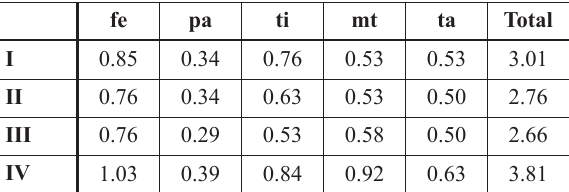
25(Fig. 3H), iridescent with a green and blue lustre. Retrocoxal hymen subglobular, hyaline.